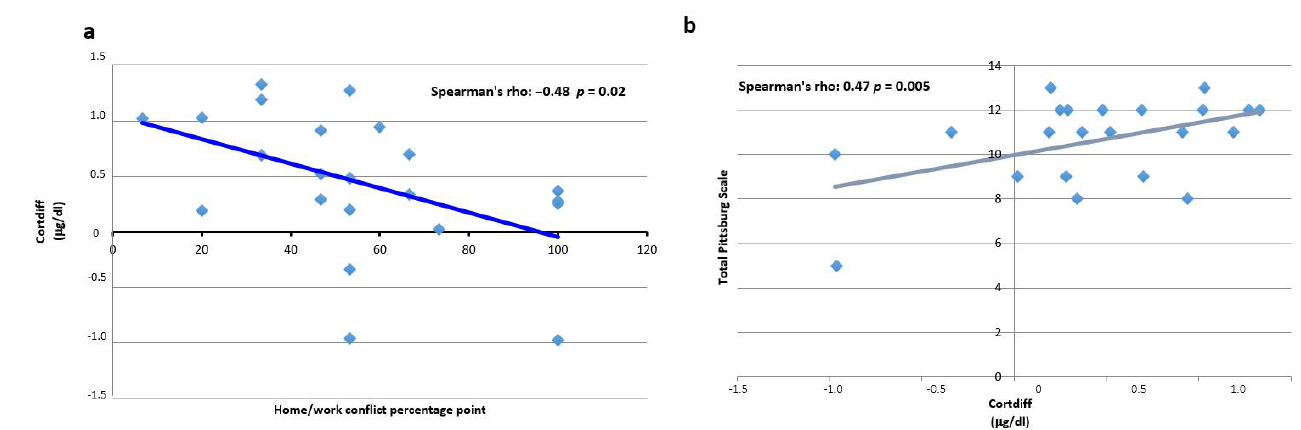
Figure 4. ( a ) Correlation of cortisol with the home–work conflict subclass and total PSQI score. The Figure 4. a) Correlation of cortisol with the home–work conflict subclass and total PSQI negative correlation between Cortdiff ( µ g/dL) and the PSS subclass home–work conflict is shown score. The negative correlation between Cortdiff (μg/dL) and the PSS subclass home– with a Spearman’s rho = − 0.48 and p = 0.02. ( b ) The positive correlation between Cortdiff ( µ g/dL) work conflict is shown with a Spearman’s rho = −0.48 and p = 0.02. b) The positive corre- and PSQI score is shown with a Spearman’s rho = 0.47 and p = 0.005. lation between Cortdiff (μg/dL) and PSQI score is shown with a Spearman’s rho = 0.47 and p = 0.005.